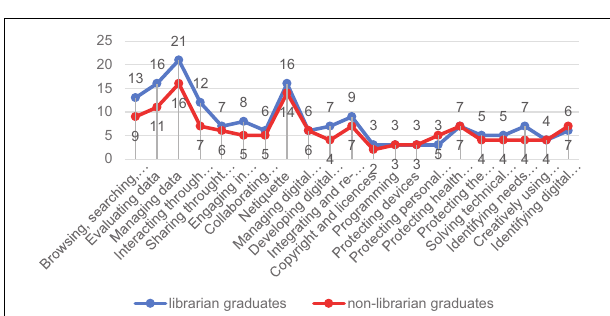
FIGURE 9 | Graduates at highly specialized level.